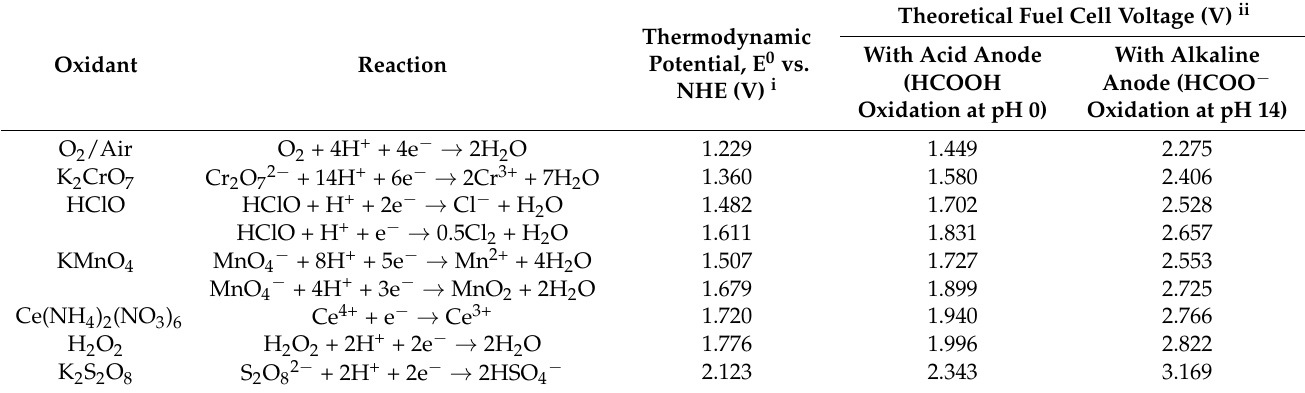
Table 1. Oxidant reactions for use in direct formic acid/formate fuel cell and theoretical cell voltages. Oxidant Reaction